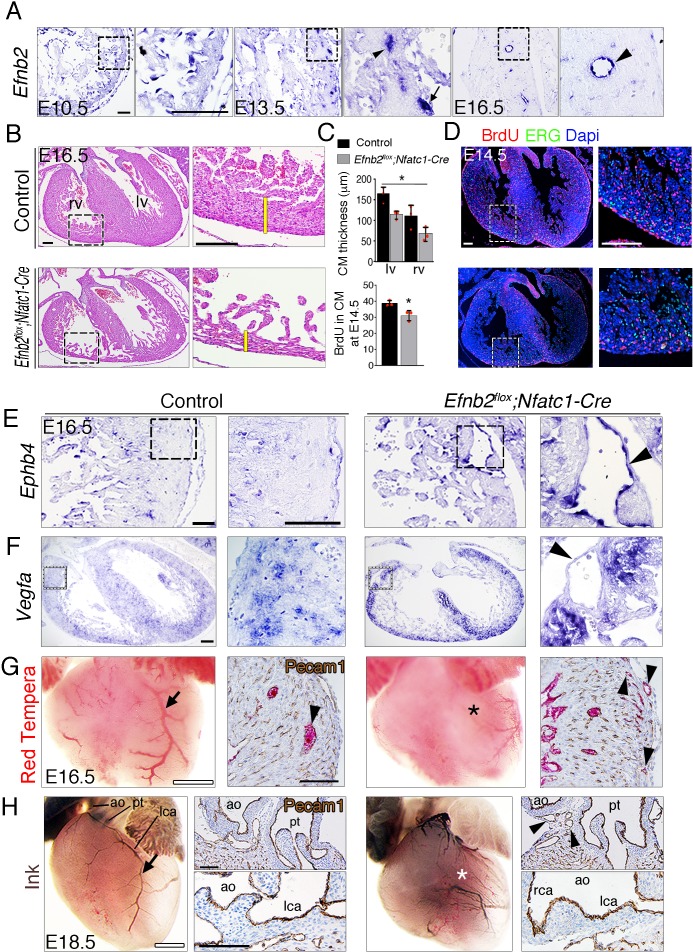
Endocardial Efnb2 deletion disrupts myocardial proliferation, arterio-venous differentiation, and arterial endothelial integrity.(A) ISH in control embryos, showing Efnb2 expression in chamber endocardium at E10.5 (arrowheads); coronary arteries (arrowheads) and a coronary vein (arrow) at E13.5; and a coronary artery at E16.5 (arrowhead). Scale bars, 50 μm. (B) H a&E staining of transverse heart sections of E16.5 control and Efnb2flox;Nfatc1-Cre hearts. Yellow bars indicate compact myocardium (CM) thickness. BrdU (red) and ERG (green) staining in E14.5 control and Efnb2flox;Nfatc1-Cre hearts. Scale bars, 100 μm. (C) Charts showing CM thickness in left ventricle (lv) and right ventricle (rv) and BrdU-stained nuclei in CM as a percentage (%) of all Dapi-stained nuclei. Data are mean ± s.d. (n = 3 sections from 3 control embryos, and n = 3 sections from 3 mutant embryos). (D) BrdU (red) and ERG (green) staining in E14.5 control and Efnb2flox;Nfatc1- Cre hearts. Scale bars, 100 μm. Microscope: Nikon A1-R. Software: NIS Elements AR 4.30.02. Build 1053 LO, 64 bits. Objectives: Plan Apo VC 20x/0,75 DIC N2 dry; Plan Fluor 40x/1,3 Oil DIC H N2 Oil. (E) ISH of the venous marker Ephb4 in E16.5 control and Efnb2flox;Nfatc1-Cre hearts, showing increased Ephb4 expression and a severe arterio-venous malformation or fistula in the mutant (arrowhead). (F) ISH of Vegfa in E16.5 control and Efnb2flox;Nfatc1-Cre hearts, showing increased Vegfa expression in myocardium and an arterio-venous fistula (arrowhead). Scale bars, 50 μm. (G) Visualization of the coronary arterial vasculature at E16.5; whole-mount heart aortic Red Tempera perfusion reveals perfusion of the left coronary artery in the control (arrow) and the absence of perfusion in the Efnb2flox;Nfatc1-Cre mutant (asterisk). Scale bars, 500 μm. Pecam-1 staining of histological sections shows larger perfused coronaries in the control heart (arrowhead) and smaller perfused coronaries in the mutant (arrowheads). Scale bars, 100 μm. (H) Visualization of the coronary arterial vasculature at E18.5; whole-mount heart aortic ink perfusion reveals perfusion of the left coronary artery (lca) in control (arrow) and its absence in the Efnb2flox;Nfatc1-Cre mutant (asterisk). Scale bars, 500 μm. Pecam-1 staining of histological sections shows numerous peritruncal vessels surrounding the pulmonary trunk (pt) in the mutant ( arrowheads), while lca rooting to the aorta (ao) is maintained. rca, right coronary artery. Scale bars, 100 μm.